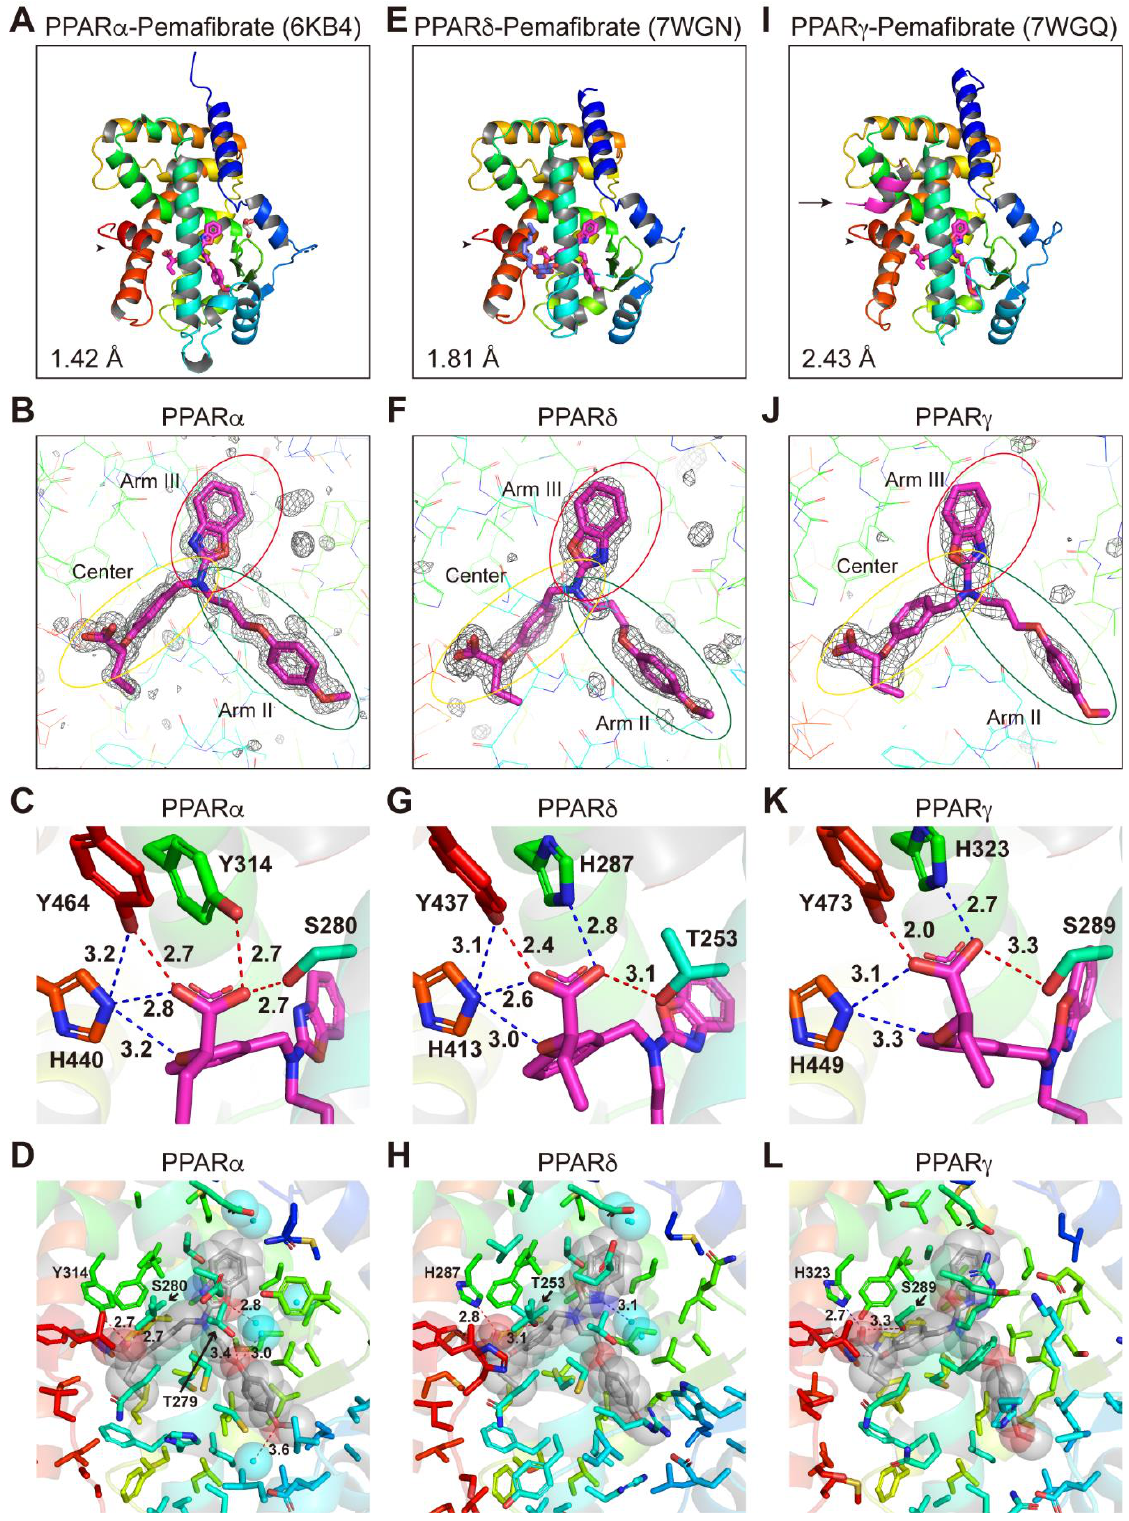
Figure 6. PPAR α / δ / γ -LBD – pemafibrate cocrystal structures. Cocrystals of pemafibrate and PPAR α -LBD ( A – D ; reprinted from Kamata et al. [6]), PPAR δ -LBD ( E – H ), or PPAR γ -LBD ( I – L ) were analyzed using X-ray diffraction. ( A , E , I ) Overall structures of the complexes. The SRC1 peptide ( α -helix in magenta) and the AF-2 helix 12 ( α -helix in red) are indicated by arrows and arrowheads, respectively. PDB identities and resolutions are labeled. ( B , F , J ) Magnified views of pemafibrate located in the Center/Arm II/Arm III regions of PPAR α / δ / γ -LBD. The electron density is shown in the mesh via F o - F c omit maps contoured at +3.0 σ . Water molecules are presented as cyan spheres. ( C , G , K ) Hydrogen bonds and electrostatic interactions between pemafibrate and the four consensus amino